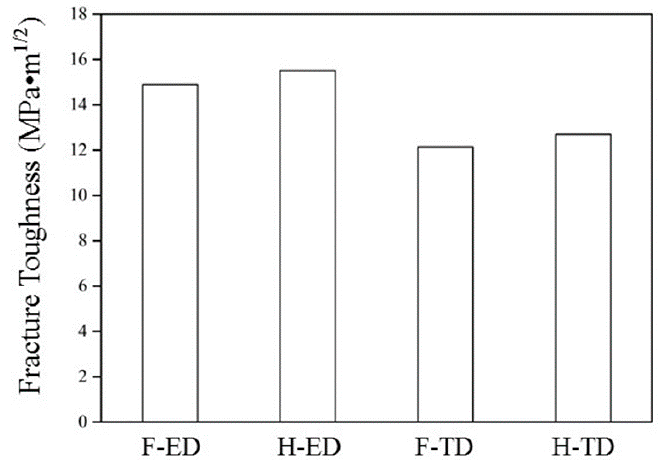
Figure 9. Fracture toughness results for XK105. (H-ED: extrusion direction of XK105-H; H-TD: transverse direction of XK105-H; F-ED: extrusion of XK105-F; F-TD: transverse of XK105-F).